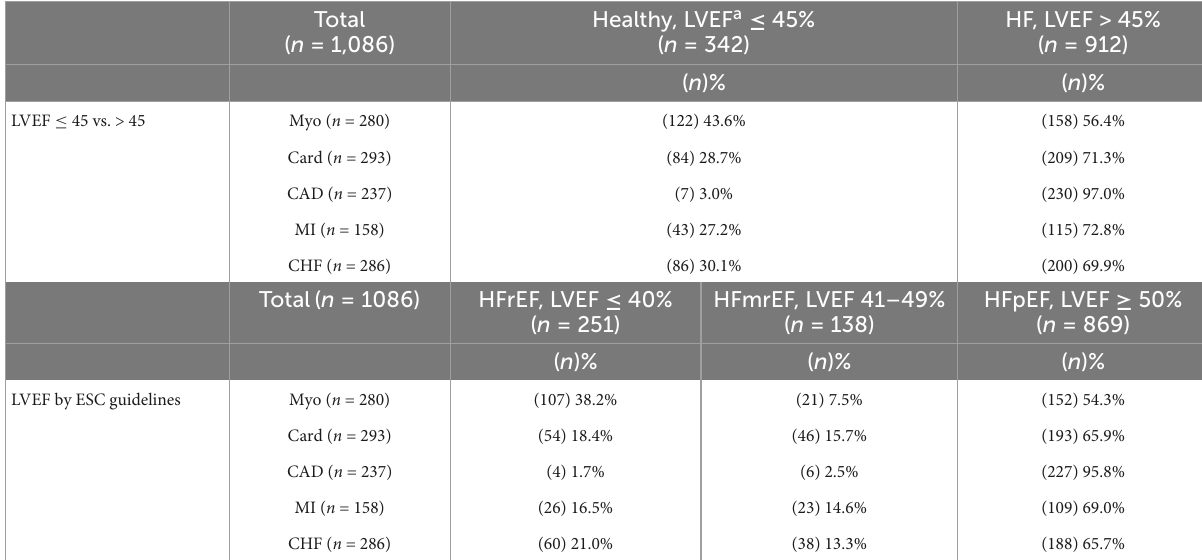
TABLE 4 Heart failure status of patients with CVDs according to LVEF ( n = 1086).